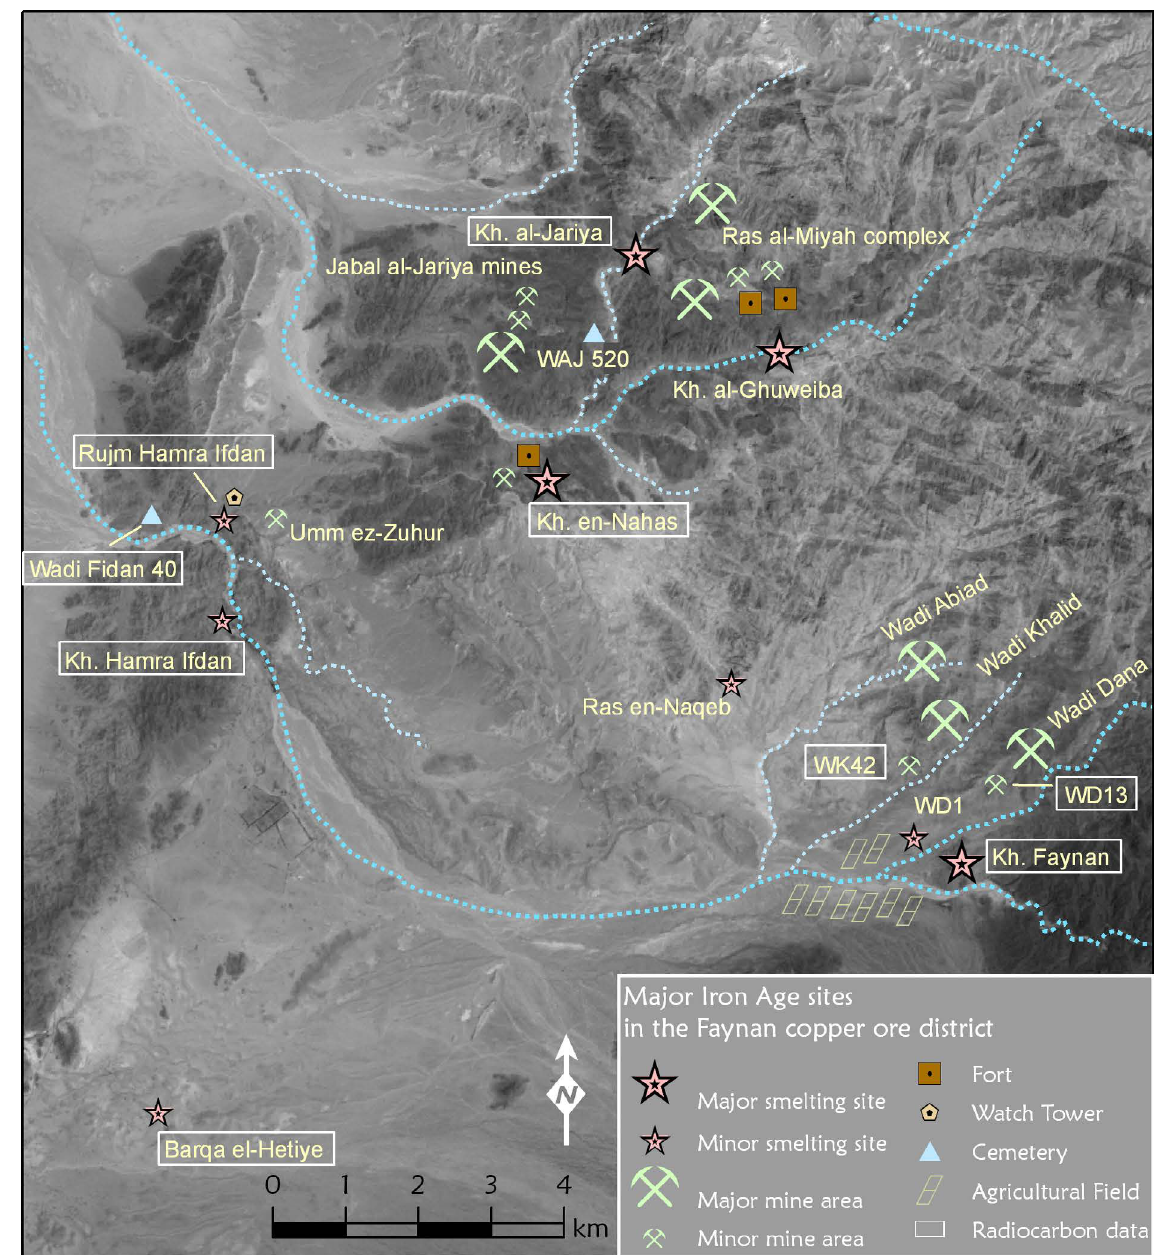
Figure 1. Map highlighting the major Iron Age sites and mining areas in the Faynan region of Jordan. The majority of these sites have been excavated and sampled by the UC San Diego Edom Lowlands Regional Archaeology Project (ELRAP) or the Deutsches Bergbau Museum. The area covers approximately 400 km 2 . Khirbat en-Nahas has produced 118 high precision radiocarbon dates from stratified contexts. (Based on Levy et al. 2012: